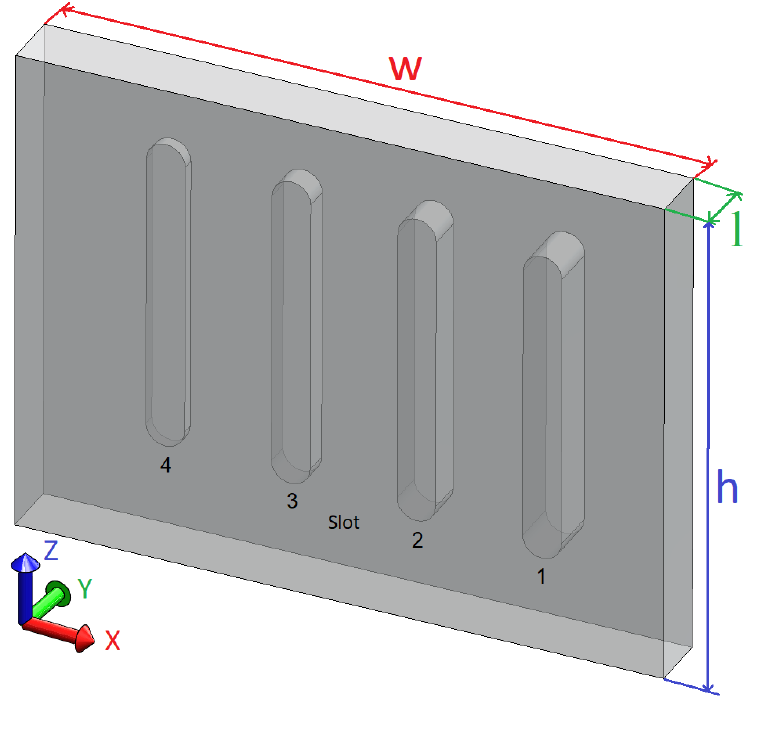
Figure 2. PMMA sample and its